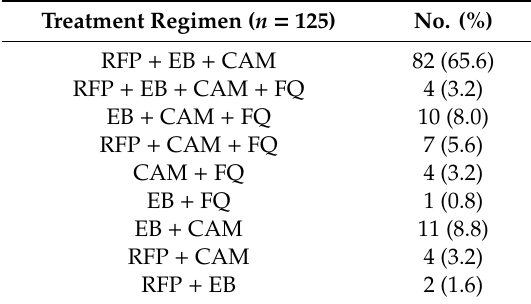
Table 1. Treatment